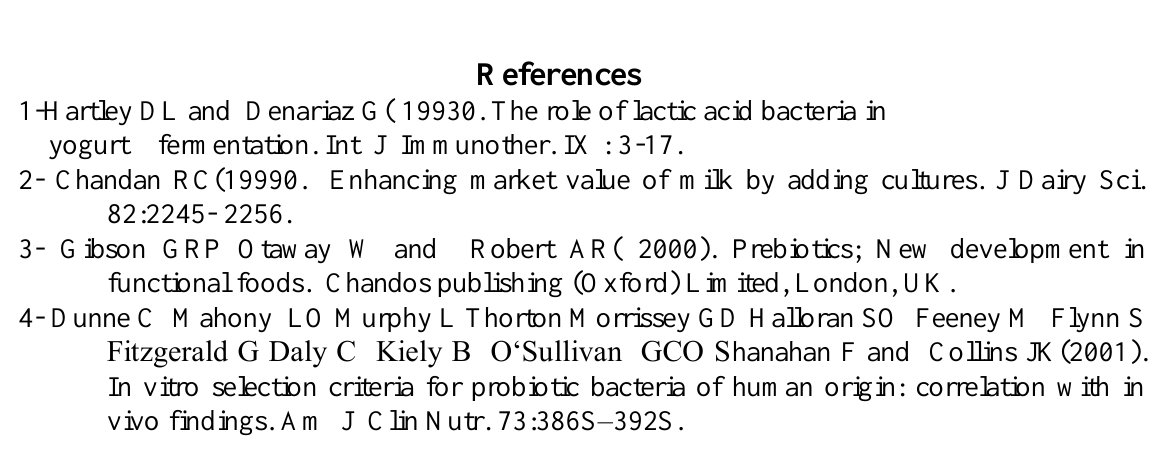
Figure 4: The influence of mild pulsed electric field ( PEF ) conditions on the protease activity of Lactobacillus delbrueckii ssp bulgaricus LB-12.